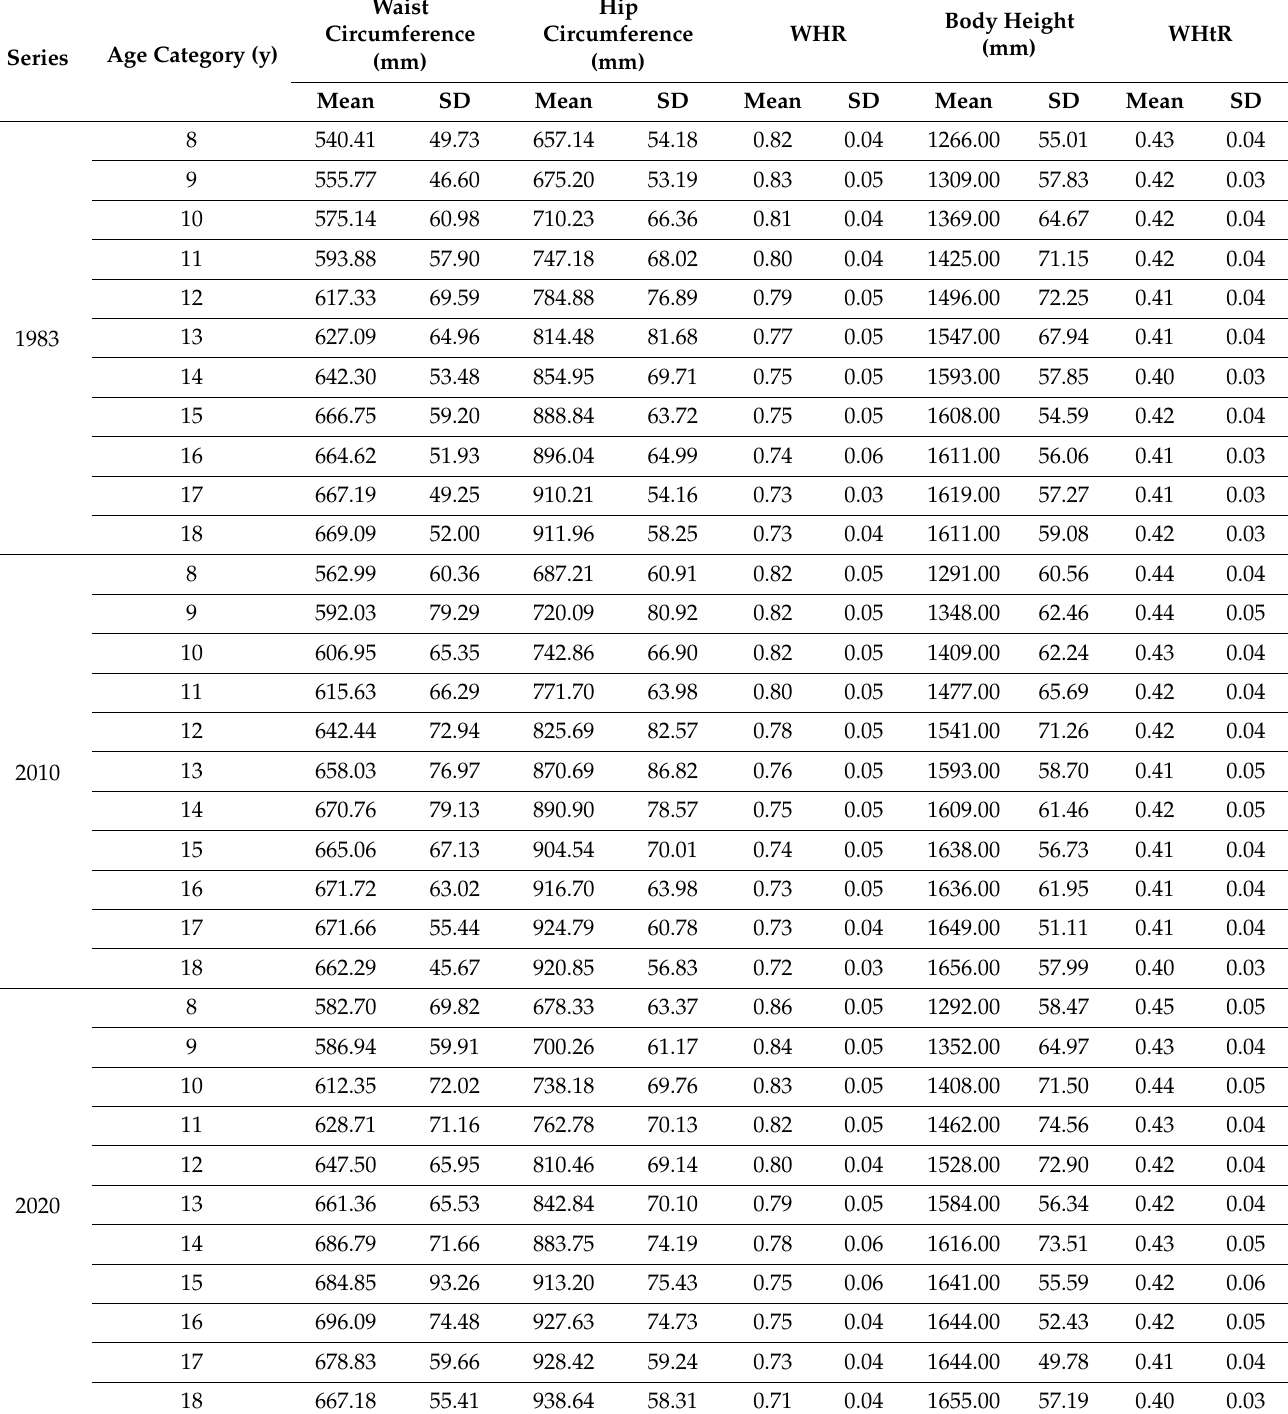
Table 2. Descriptive statistics for girls—means and Standard Deviations (SDs) for the analyzed